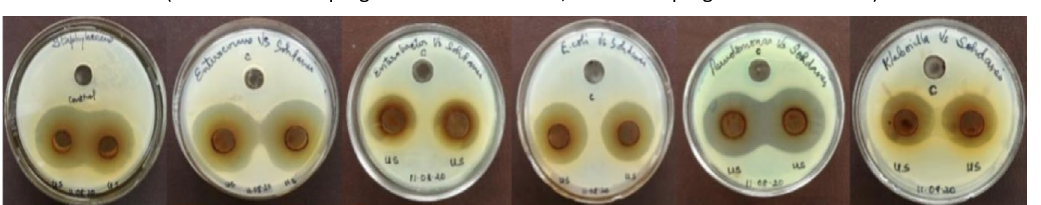
Fig. 3. Plates of Disc diffusion assay showing antibacterial activity of G. pedunculata methanol extract on UTI clinical bacterial isolates. (C=control disc impregnated with methanol; US=disc impregnated with MEGP).